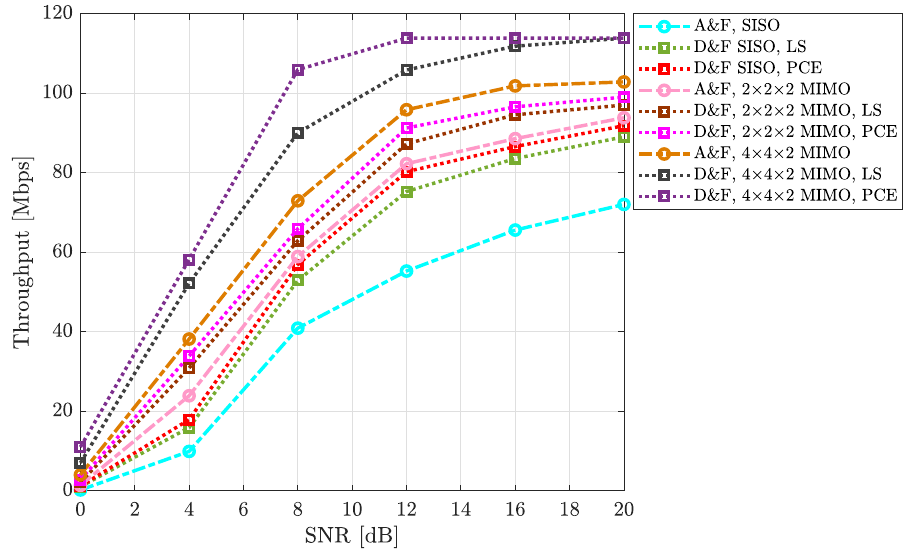
Figure 12. Throughput vs. SNR of the cooperative system; 64-QAM